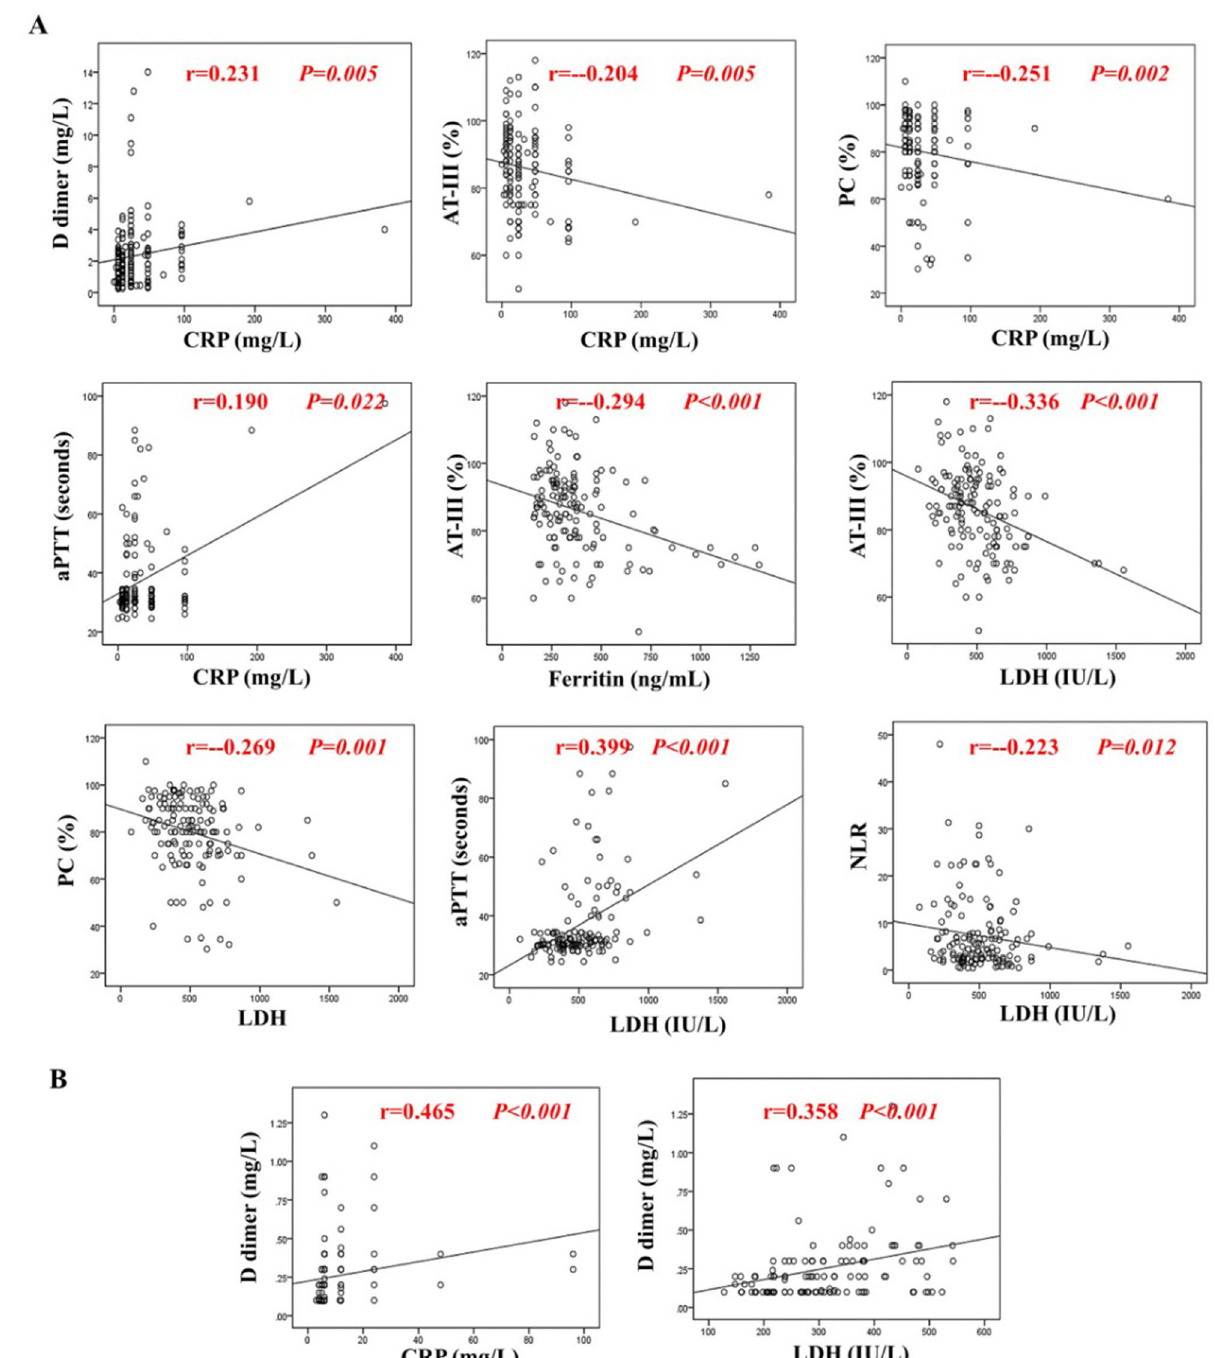
Figure 1. Schematic box plots representing the correlations of coagulation parameters (PC, aPTT, Fibrinogen, AT-III, and d-dimer) with inflammatory parameters (CRP, ferritin, NLR and LDH) among hospitalized (144) cases ( A ), and non- hospitalized (123) cases ( B ). LDH lactate dehydrogenase, CRP C-reactive protein, PC prothrombin concentration, aPTT activated partial thromboplastin, ATT-III antithrombin-III, NLR neutrophil- to-lymphocyte ratio, r Spearman rank correlation coefficient, P P